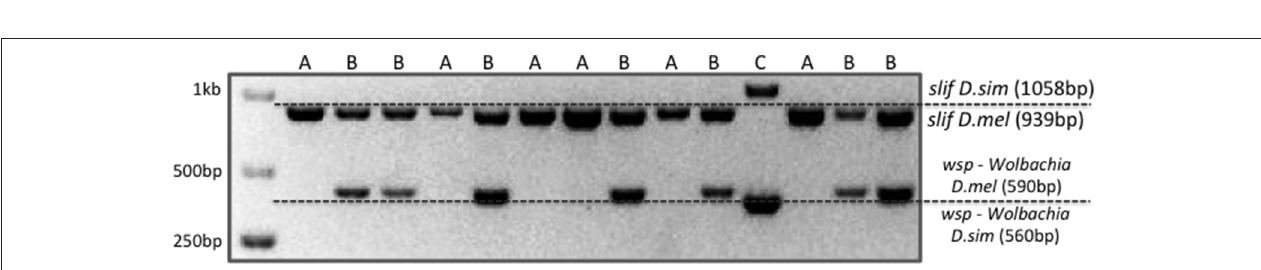
FIGURE 3 | Rapid Drosophila species identification and infection status by multiplex PCR. Each lane contains the PCR amplification products using Wolbachia specific primers and primers for the gene slif . In both cases, amplification products have distinctive sizes that allow identification of the species and determination of Wolbachia infection status. Letters A, B, or C refer to D. melanogaster / Wolbachia -negative, D. melanogaster / Wolbachia -positive and D. simulans / Wolbachia -positive samples, respectively.